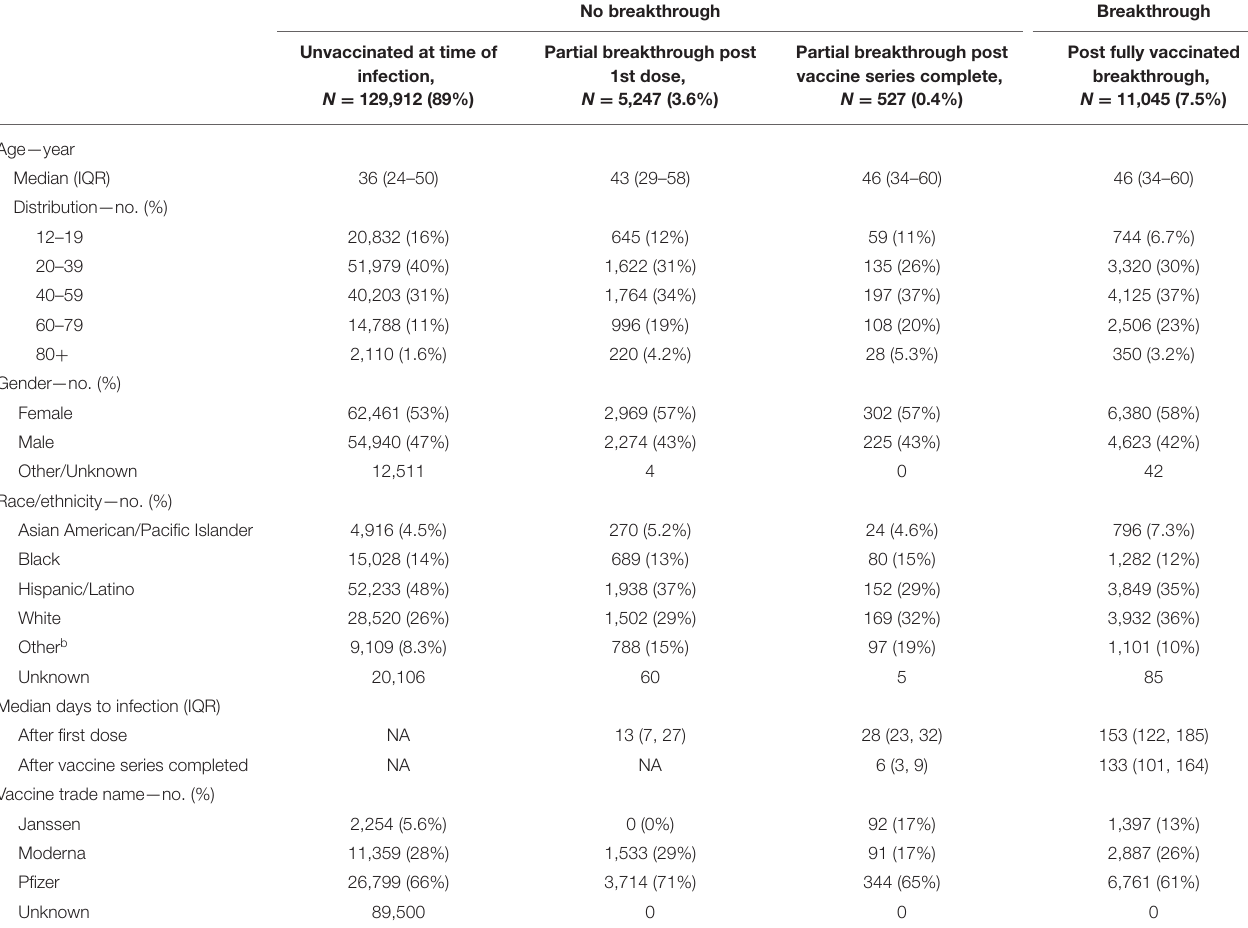
TABLE 1 | Descriptive statistics of 146,731 individuals 12 years or older in Harris County (excluding City of Houston jurisdiction) with a positive SARS-CoV-2 molecular test between 12/14/2020 and 09/30/2021 and their vaccination category a